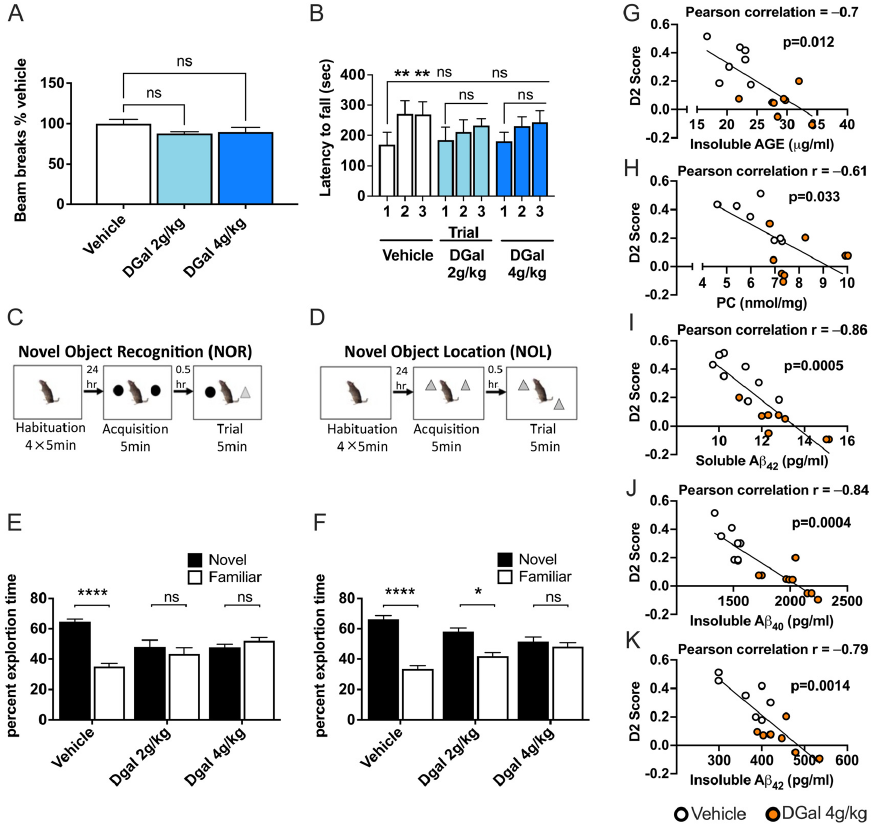
Figure 5. oDGal treatment promotes multi-domain cognitive deficits without affecting motor coor- dination or activity. ( A ) Average locomotor activity represented by number of beam breaks over a one-hour period for mice dosed chronically over 8 weeks with vehicle, 2 g/kgoDGal, or 4 g/kgoDGal. Data are presented as a percentage of the vehicle group. Data are presented as mean ± SEM, ana- lyzed by one-way ANOVA followed by Dunnett’s multiple comparison test. ( B ) Latency for animal to fall from an accelerating rotarod. Mice were dosed chronically over 8 weeks with vehicle, 2 g/kgoDGal or 4 g/kgoDGal. Data were analyzed using a two-way repeated measures mixed model approach, with treatment factor treatment ( F (6, 58) = 0.28, p = 0.95), repeated factor trial ( F (2, 116) = 19.20, p < 0.001). Schematic representation of NOR ( C ) and NOL ( D ) tasks, where circles and squares rep- resent objects used for the study. ( E ) NOR task represented as a percentage exploration time of fa- miliar and novel objects for mice dosed chronically over 8 weeks with vehicle, 2 g/kgoDGal or 4 g/kgoDGal. Data were analyzed by Kruskil–Wallis test ( p = 0.0001) followed by Dunnett’s multiple comparison test. ( F ) NOL task represented as a percentage exploration time of familiar and novel locations for mice dosed chronically over 8 weeks with vehicle, 2 g/kgoDGal or 4 g/kgoDGal. Data were analyzed by Brown–Forsythe and Welch ANOVA ( F (5, 25.96) = 29.99, p = 0.0001) followed by Dun- nett’s T3 multiple comparison test. Discrimination index (D2) score, calculated from the hippocam- pal spatial cognitive score, correlated significantly with levels of hippocampal insoluble AGE ( G ), PC ( H ), soluble A β 42 ( I ), insoluble A β 40 ( J ) or insoluble A β 42 ( K ) in mice dosed chronically over 8 weeks with 4 g/kgoDGal or vehicle (Veh), determined by Pearson’s rank correlation coefficient (r). Asterix (*) represent significant changes: * p < 0.05, ** p < 0.01, **** p < 0.0001, ns=non-significant. All data are presented as a mean ± SEM percentage vehicle.